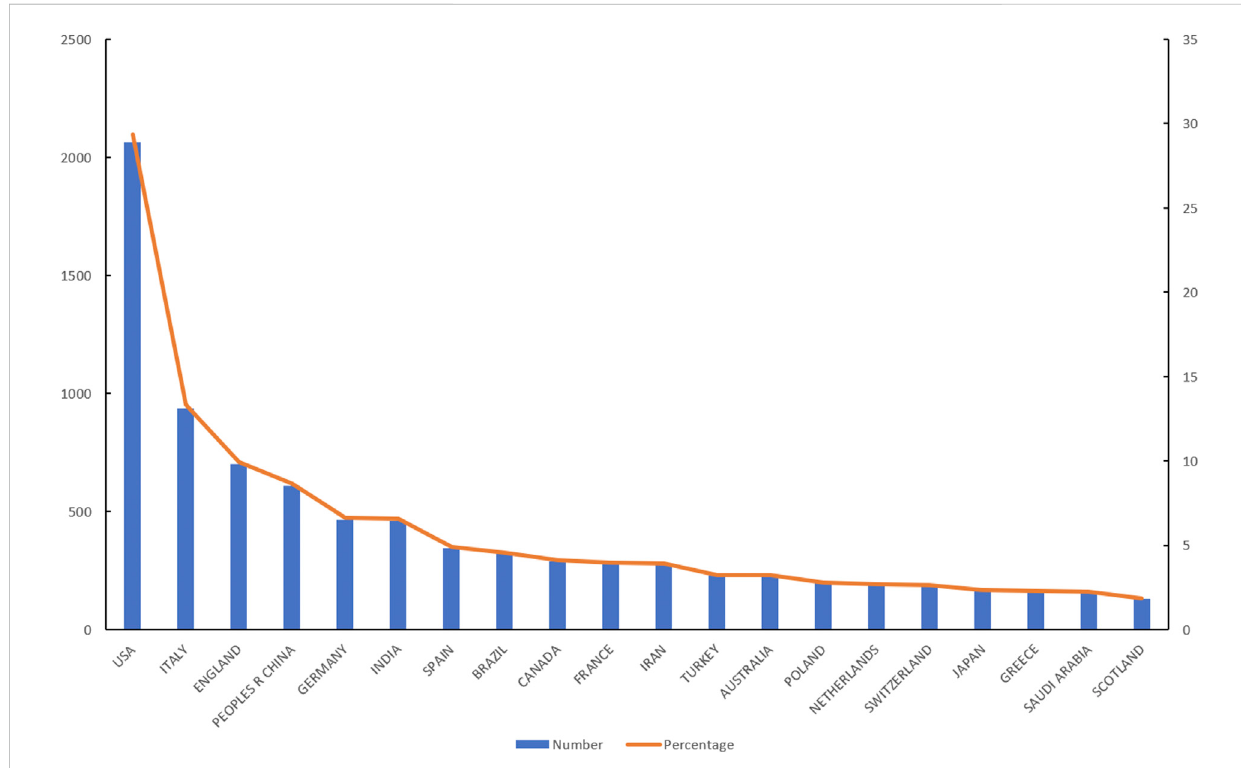
FIGURE 4 The top 20 countries with the most articles.